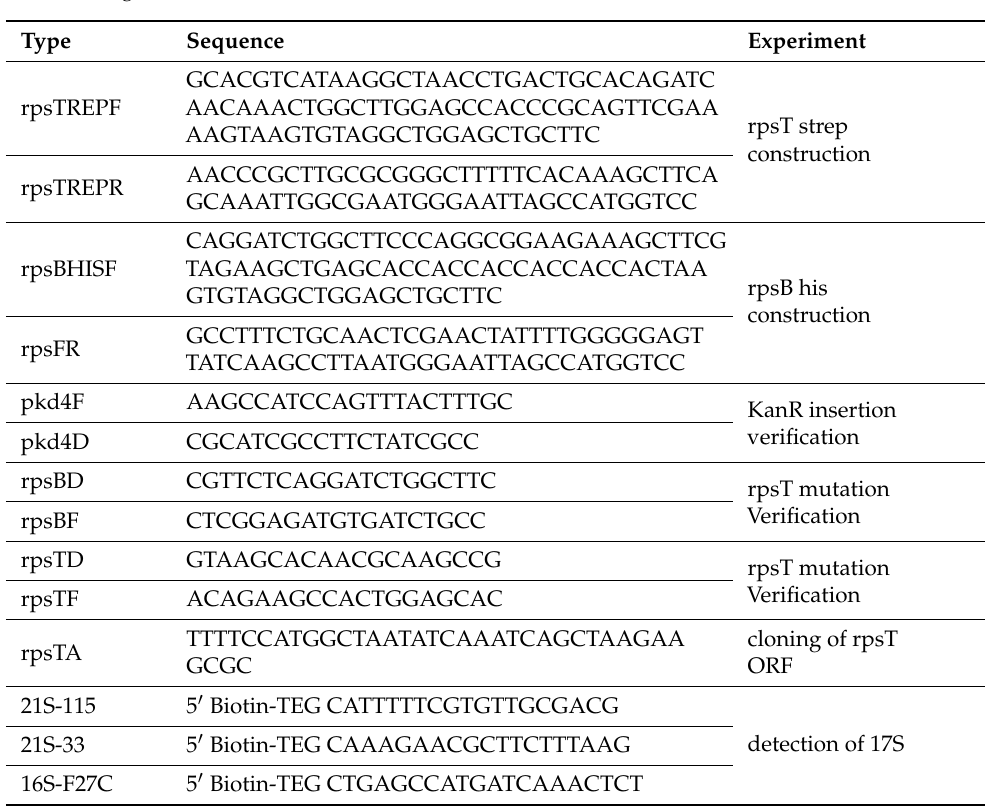
Table 2. Oligonucleotides